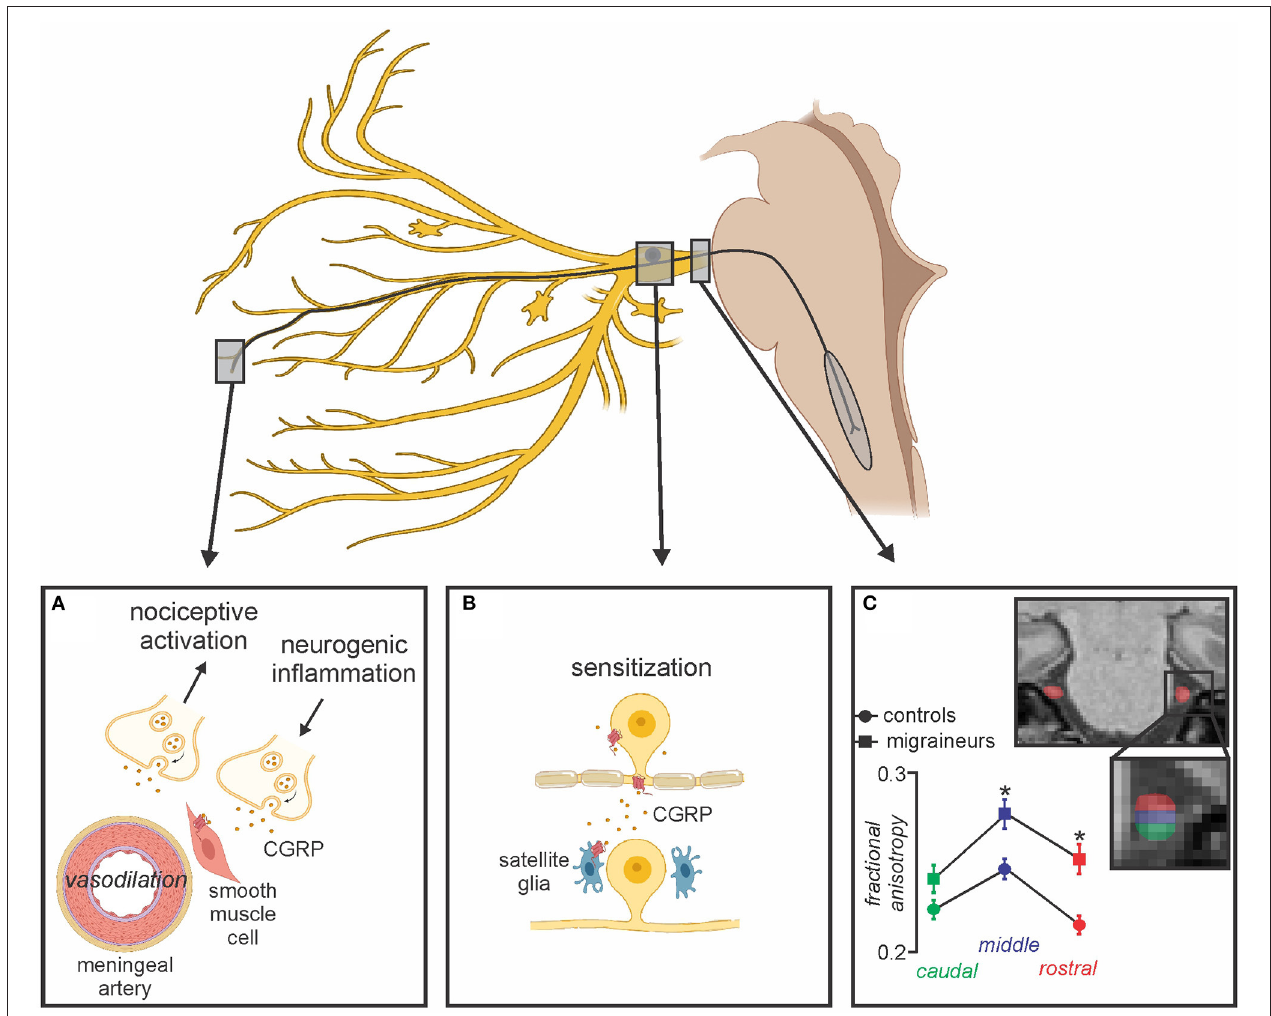
FIGURE 2 | Peripheral changes associated with migraine. (A) CGRP released from peripheral terminals onto receptors act on smooth muscle cells leading to potent vasodilation of meningeal arteries, subsequent neurogenic inflammation, activation of meningeal nociceptors and peripheral sensitization; (B) Secreted CGRP from the trigeminal ganglion interacts with adjacent CGRP receptors on satellite glia resulting in prolonged sensitization; (C) Alterations in trigeminal nerve volume and free water diffusivity evident in episodic migraineurs compared to healthy controls may also be associated with chronic migraine. Modified from